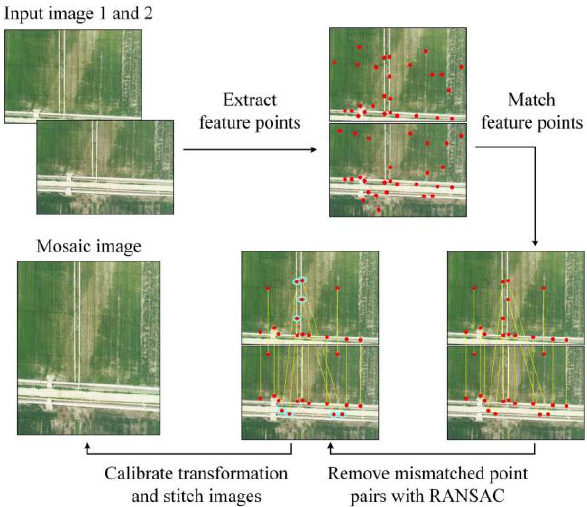
Figure 1. Flowchart of standard scale-invariant feature transform (SSIFT)-based image mosaicking.